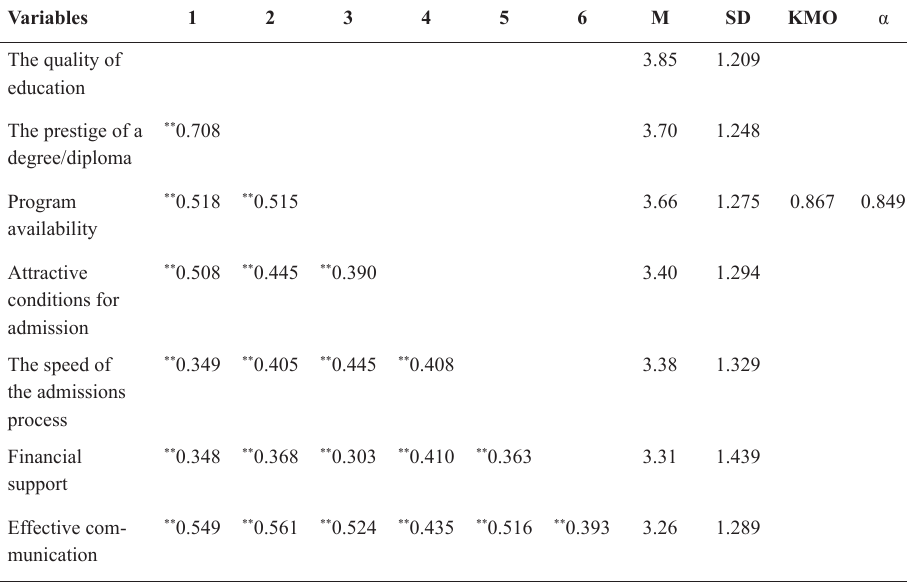
Table 5. African students’ mesosystem/institutional